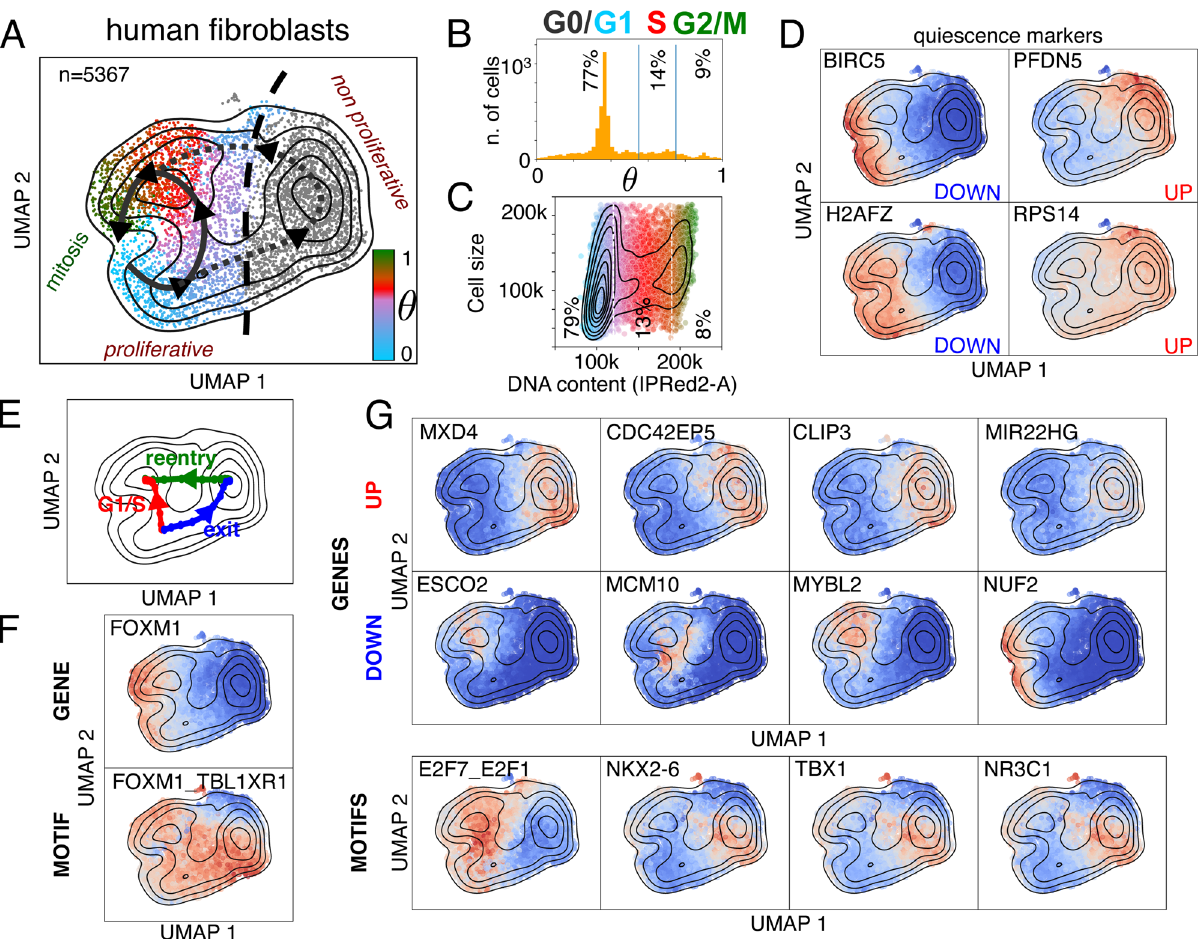
Fig. 5 G1/S transition and cell-cycle exit in human fi broblasts. A The two subpopulations of human fi broblasts, separated by the black dashed line: on the left side the proliferative cells, and on the right the nonproliferative. Each cell is colored according to its inferred transcriptional phase. B The distribution of transcriptional phases for the human fi broblasts shows the nonproliferative fi broblasts are closer to the cell cycle stage associated to θ = 0.3 – 0.4 (mid-G1). C Flow cytometry analysis recapitulates fractions of cells in the main phases of the cell cycle similar to the phases identi fi ed with DeepCycle. The cells in G0/G1 can be bigger than the cells in G2/M. The colors are consistent with panel A, G1 in blue, S in red, and G2M in green. D Examples of G0 marker expressions for the two subpopulations 64 . BIRC5 is also known as survivin. Color intensity reprsents gene expression upregulated level (red) and downregulated level (blue). E The paths, going from mid-G1 towards the S phase (in red and labeled as ‘ G1/S ’ ), from the mid-G1 phase towards the nonproliferative state (in blue and labeled as ‘ exit ’ ), and the nonproliferative state toward the S phase (in green and labeled as ‘ reentry ’ ), are identi fi ed by the higher density of cells. F FOXM1 is downregulated in the nonproliferative cells and shows the opposite trend along the G1/S and exit paths (red and blue paths in panel E). The activity of its motif is completely uncorrelated with its expression. G The top up- and down-regulated genes with the strongest fold changes, compare the paths in E . The third row shows the most signi fi cant motif activities identi fi ed by comparing the paths in E . Color intensity reprsents either gene expression or motif activity (red: upregulation; blue: